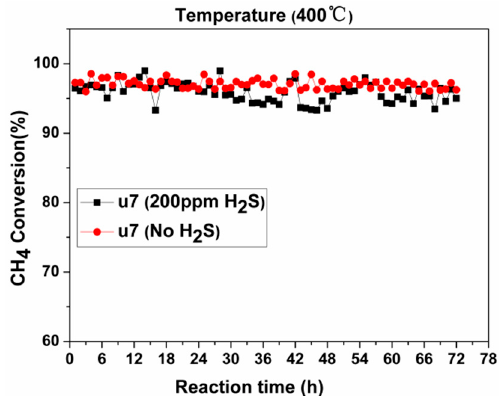
Figure 11. Long-term stability test of the u7 catalyst with and without H 2 S. Gas composition: CH 4